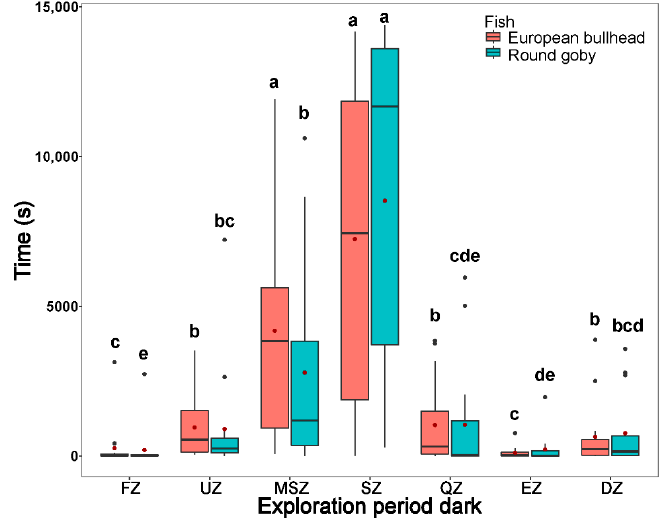
Figure 2. Time spent by Cottus gobio (red) and Neogobius melanostomus (turquoise) in channel zones during acclimatization periods: stress ‐ response period (upper box plot), exploration period in light (middle box plot), and exploration period in dark (lower box plot). Box limits correspond to upper (Q3—75%) and lower (Q1—25%) quartiles, horizontal bar to the median, and red dot to the mean. Outliers are indicated by points (min = Q1 − 1.5 * IQR; max = Q3 + 1.5 * IQR). FZ = feeding zone, UZ = upstream zone, MSZ = mid ‐ stream zone, SZ = shelter zone, QZ = quiet zone, EZ = escape zone, DZ = downstream zone. Values with different letters indicate significant differences ( α = 0.05); asterisk indicates significant interspecific differences.